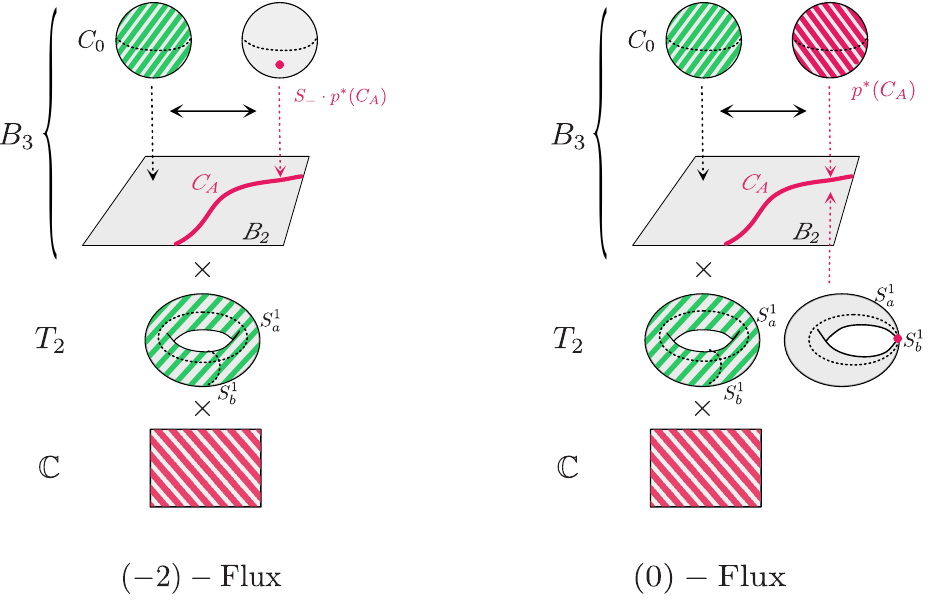
Figure 4 . Shown is the interplay of the string and flux geometry for the rational fibrations B 3 → B 2 which we consider as an example, referring to the geometry (5.2) in the Type IIB duality frame. The green hatching shows the wrapping locus of the D3-brane that leads to a heterotic string which is further compactified on S 1 to two dimensions. The red hatching shows the loci of the “flux” × S 1 a b branes that encode the background